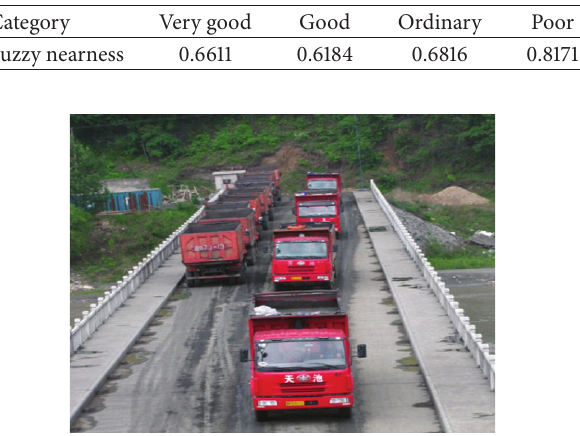
Figure 4: Traffic volume of Nanping